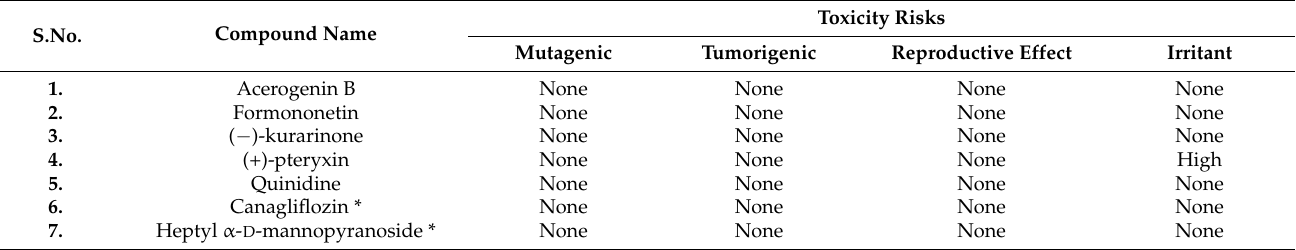
Table 2. Toxicity potential of natural SGLT2 inhibitors and control compounds.